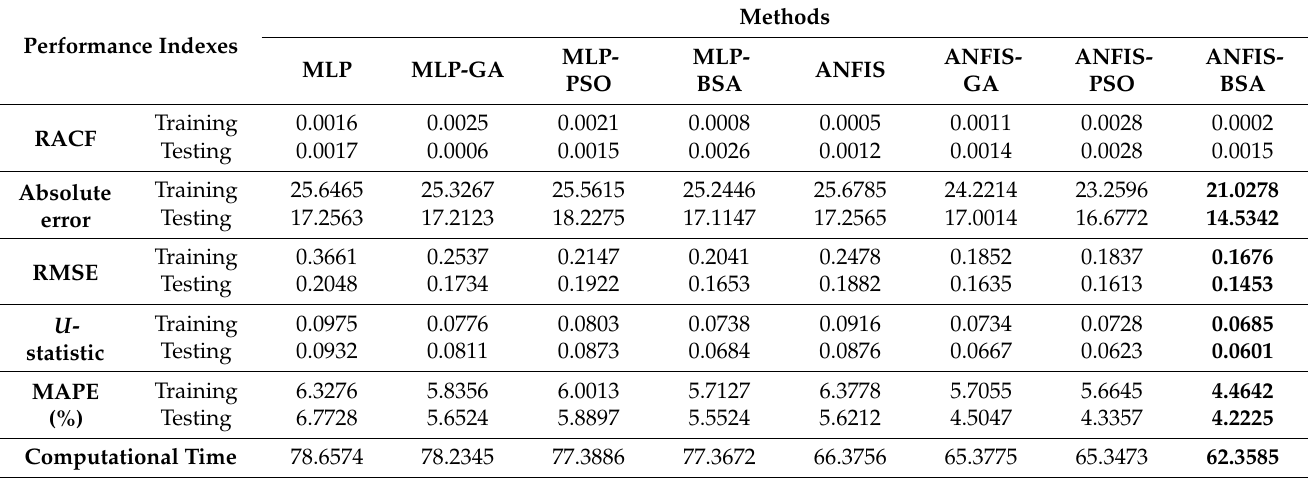
Table 7. Comparison performance indexes of multiple metaheuristic techniques corresponding to the forecasting accuracy for EPF on August 2018 in